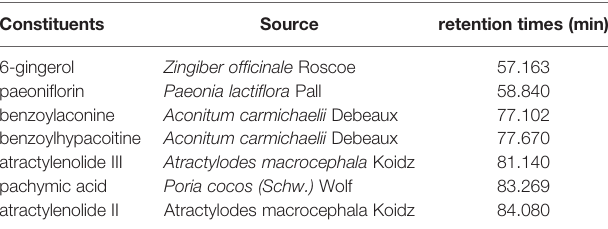
TABLE 2 | Herbal sources and retention times of seven components in Zhen- wu-tang (ZWT).